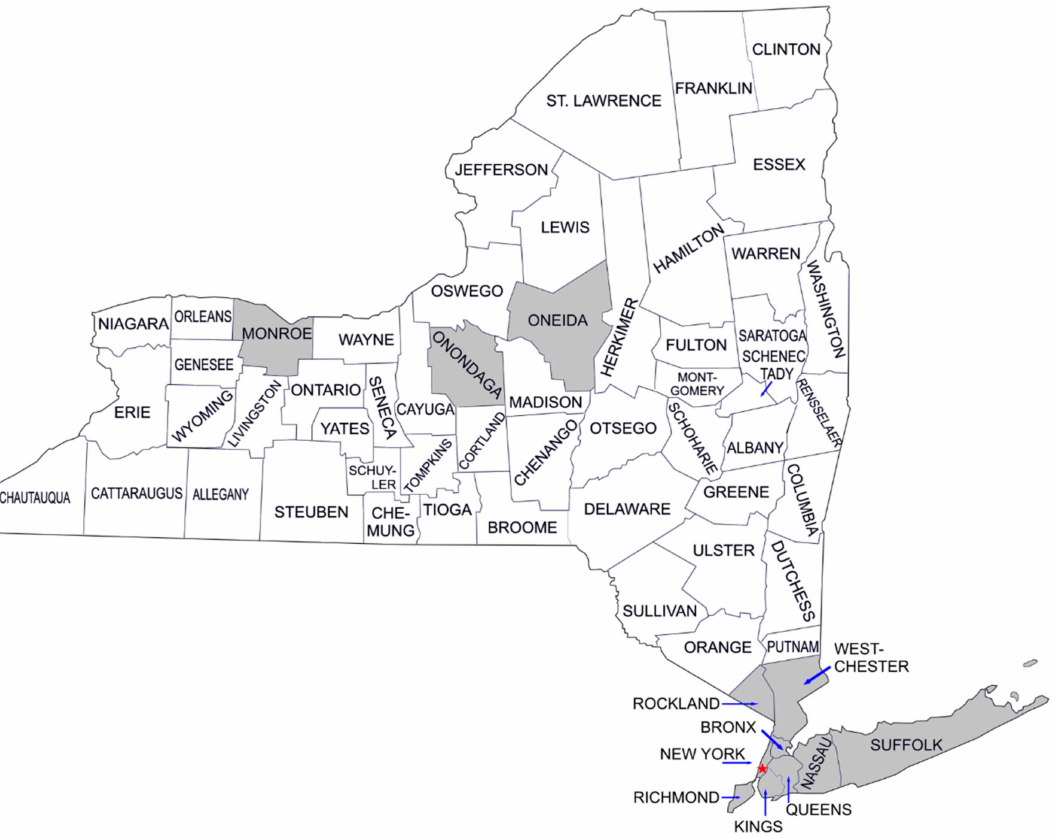
Figure 2. New York State map (studied counties: in grey).